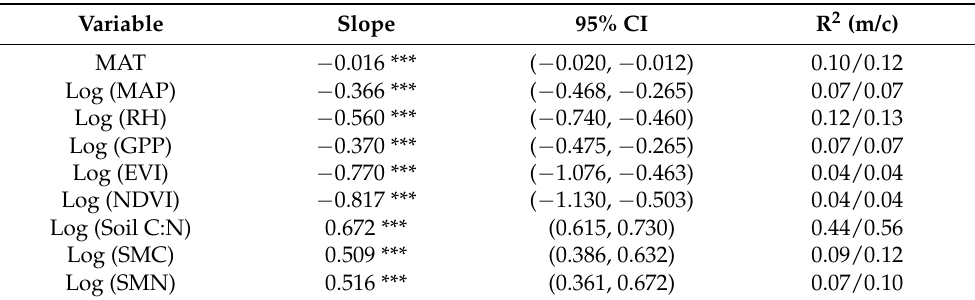
Table 2. Statistics of GLMM relating climatic, vegetation, and soil variables with τ .